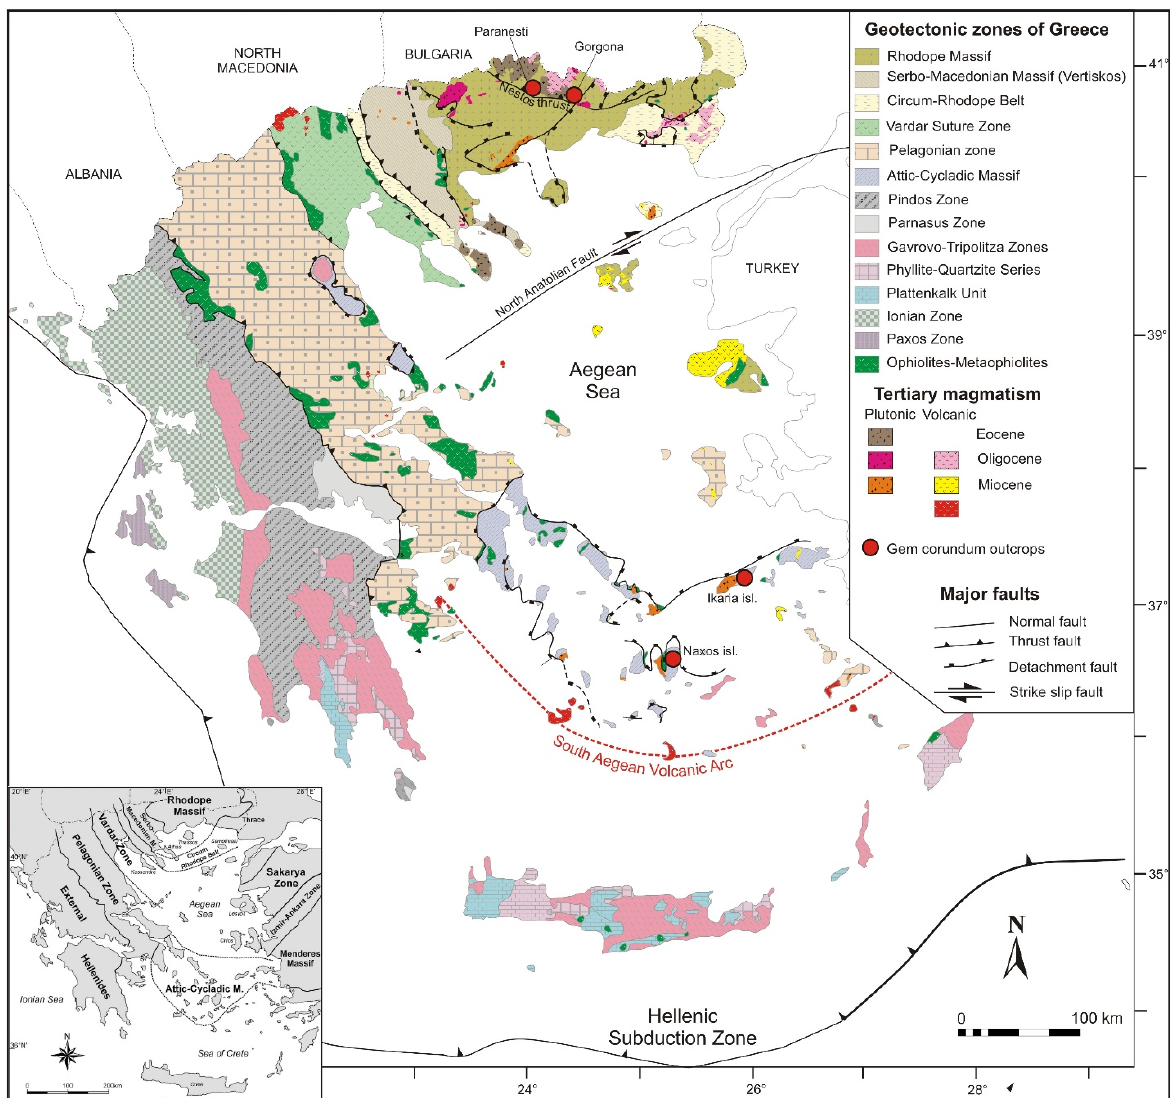
Figure 1. Simplified map of Greece showing the main geotectonic zones, the major tectonic structures within the Hellenides, and the distribution of the gem corundum (rubies and sapphires) in Paranesti, Gorgona, Ikaria island and Naxos island of Greece. The geotectonic zones of the Hellenic orogen are shown in the inset.